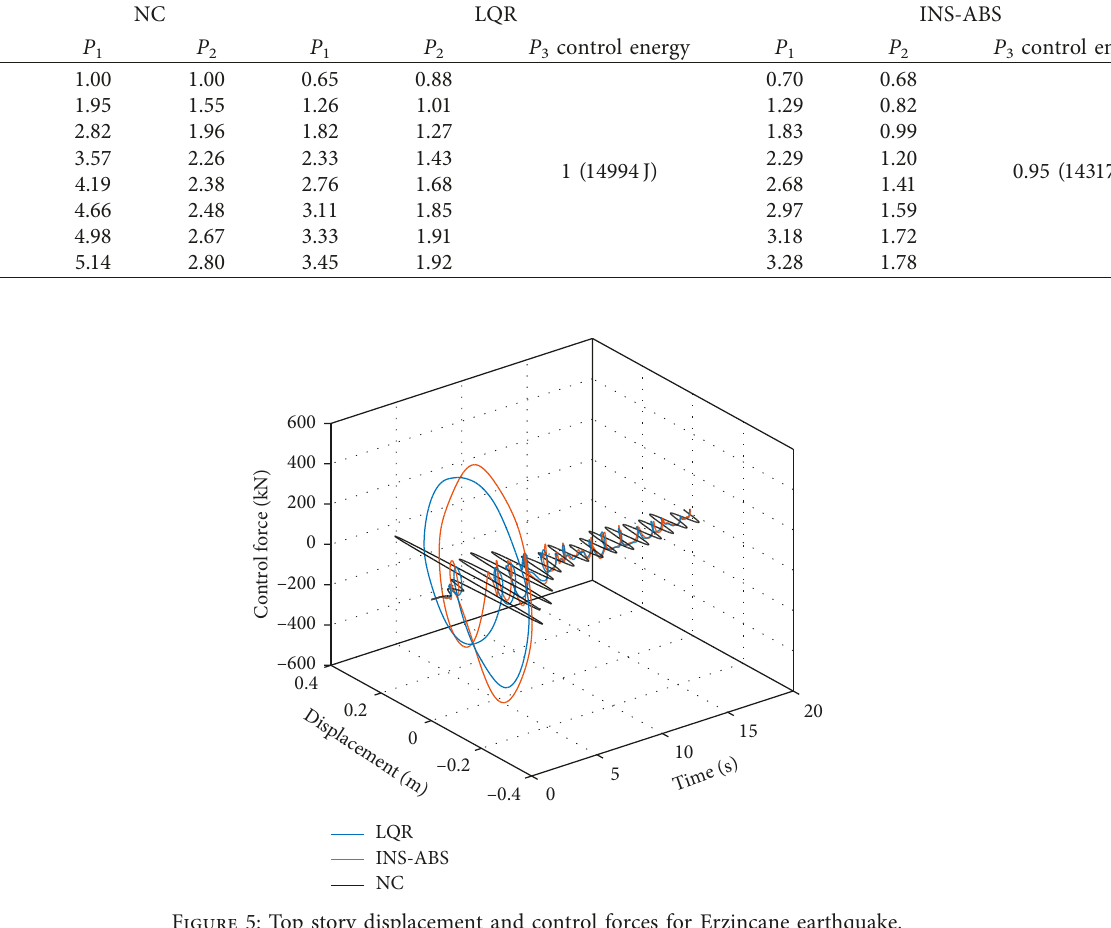
Table 3: Comparison measures for El Centro earthquake.